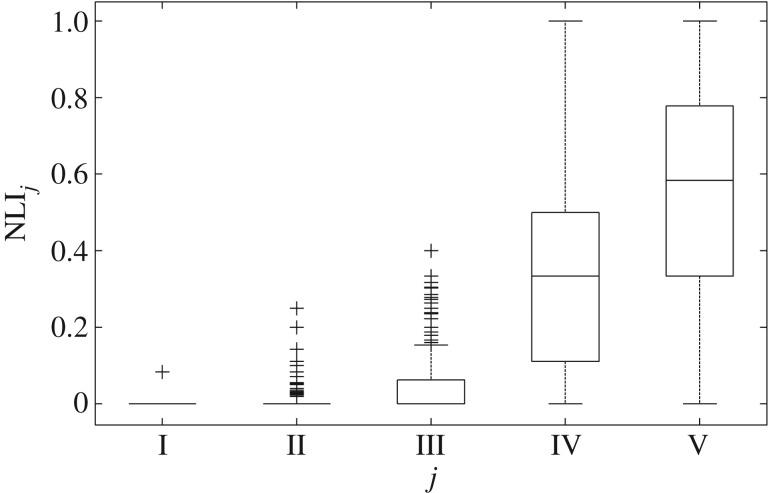
Distribution of the NLIj, j = I, II, …, V, values (adapted from Taplidou & Hadjileontiadis [17]).